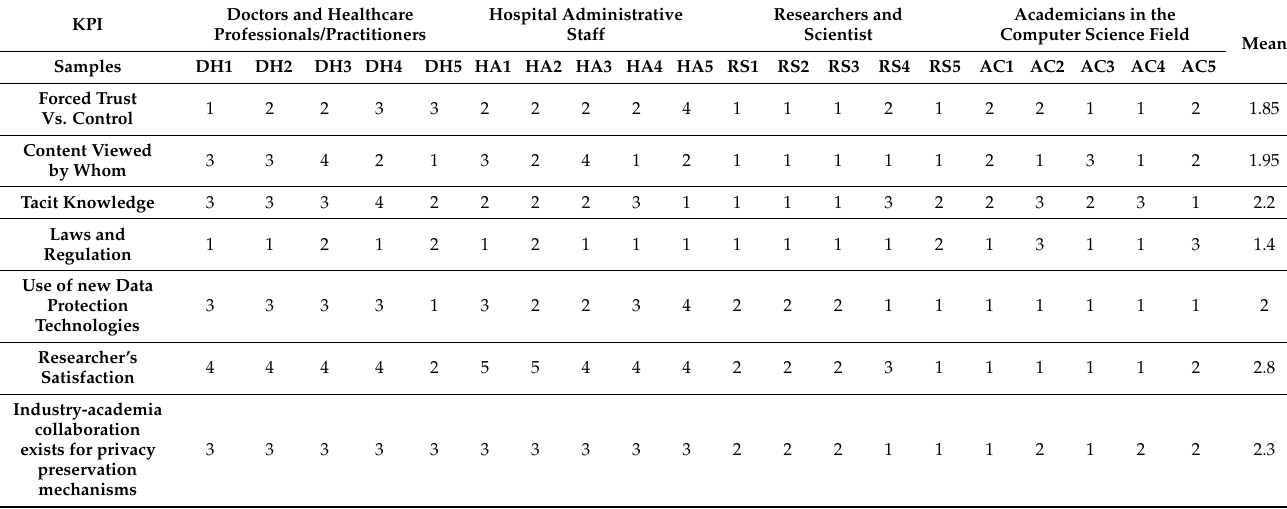
Table 11. Ratings of KPIs defined over privacy issues by healthcare